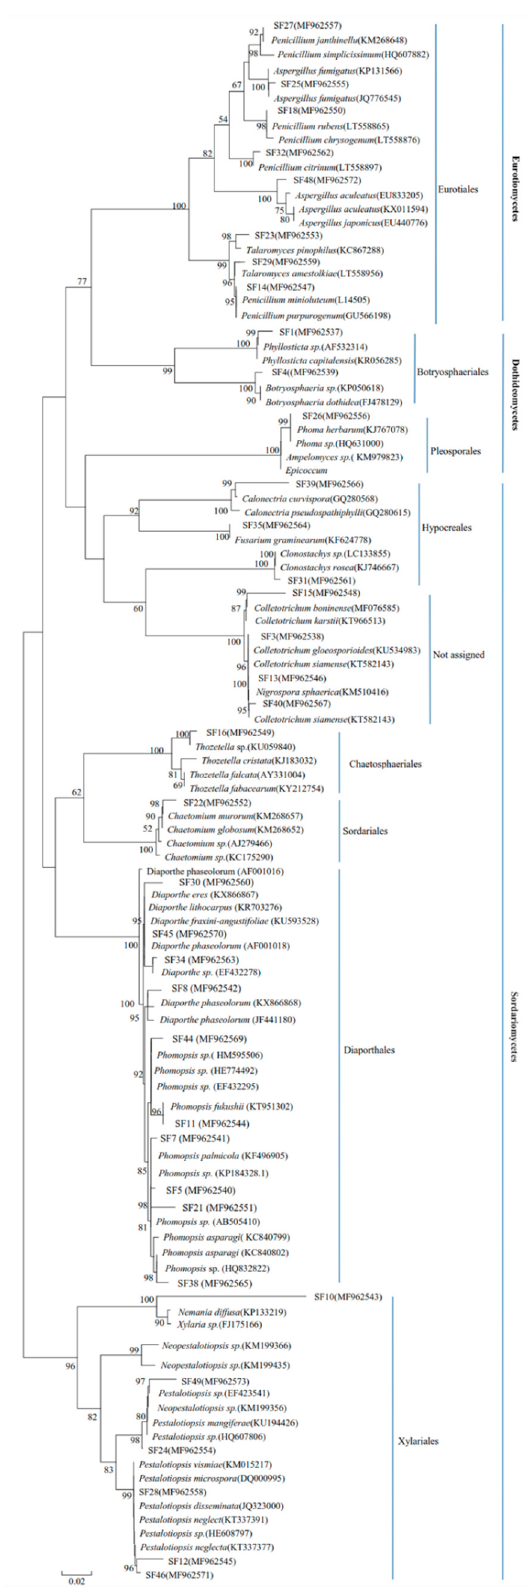
Figure 1. Neighbor-joining phylogenetic tree based on internal transcribed spacer (ITS)–rDNA gene sequences of endophytic fungi associated with Litsea cubeba (Lour.) Pers. Bootstrap percentages (>50) after 1000 replications are shown.